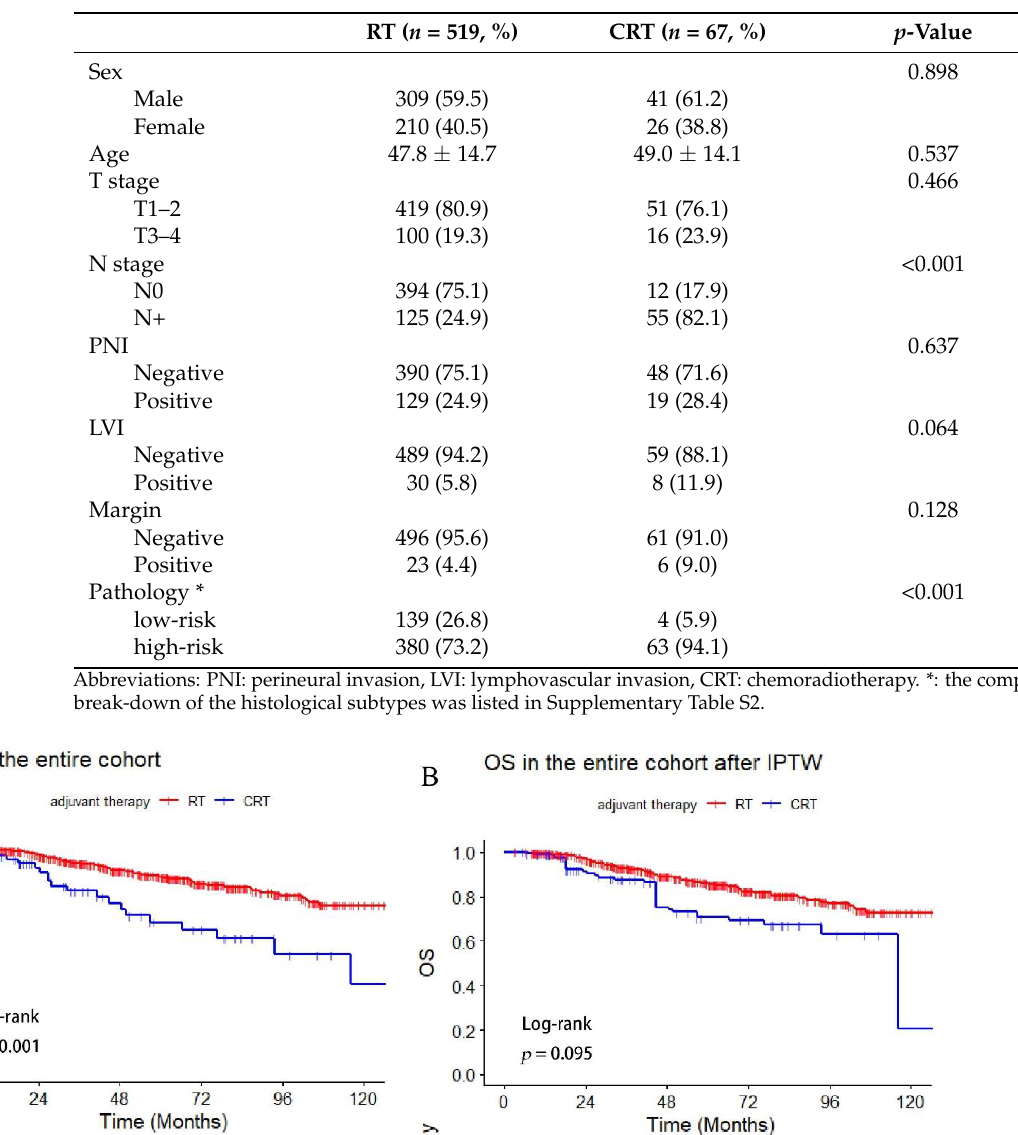
Table 3. The baseline characteristics in the RT and CRT groups.